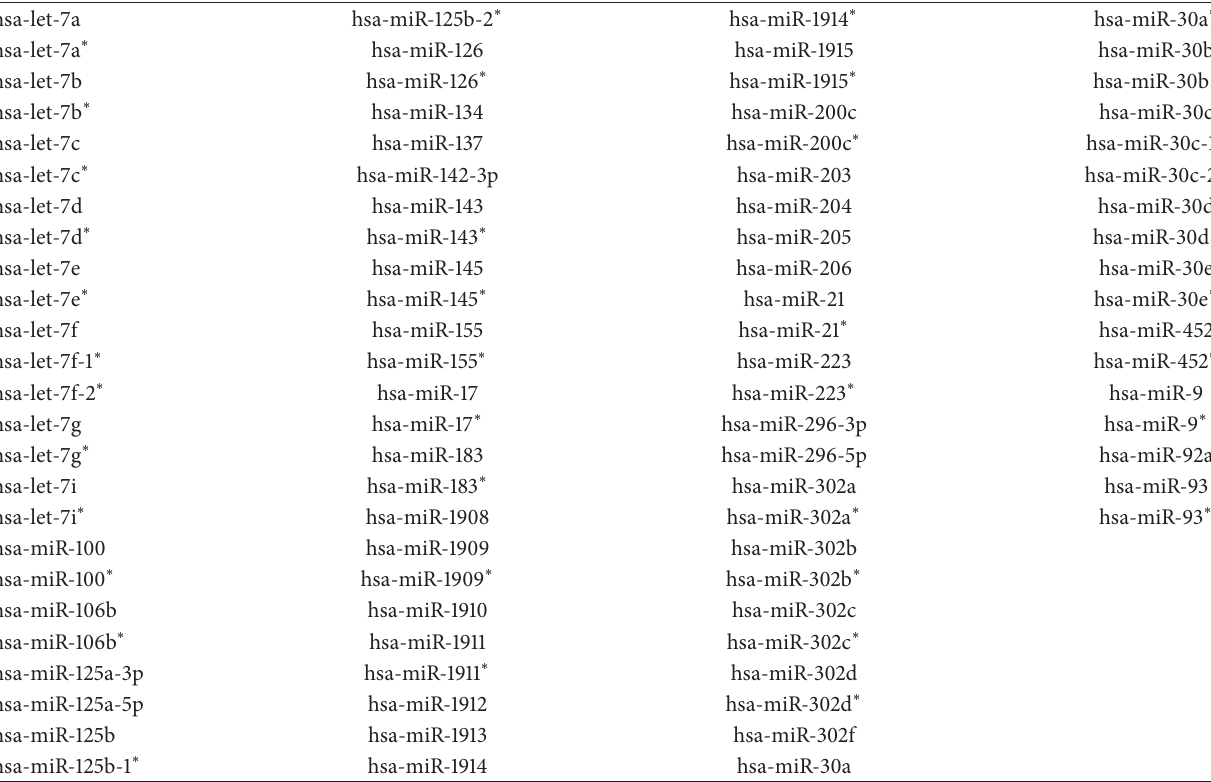
Table 1: microRNAs that have been reported in the literature to regulate the main transcript from the SOX2 locus.